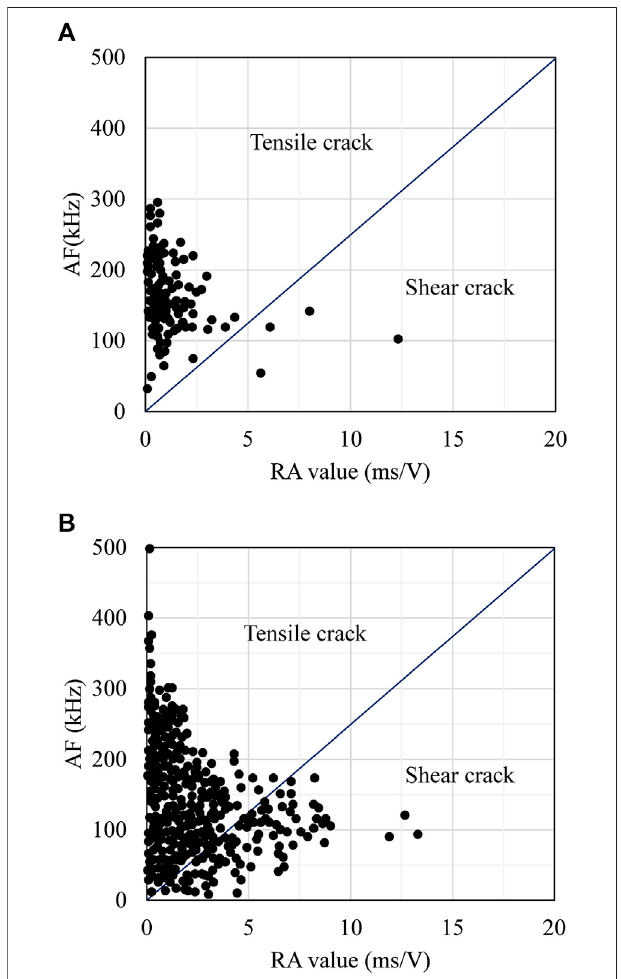
FIGURE2| Type ofcracks generatedin thecementitious material under cyclic tensile loading: (A) without fi ber reinforcement, and (B) with fi ber reinforcement (Li et al.,